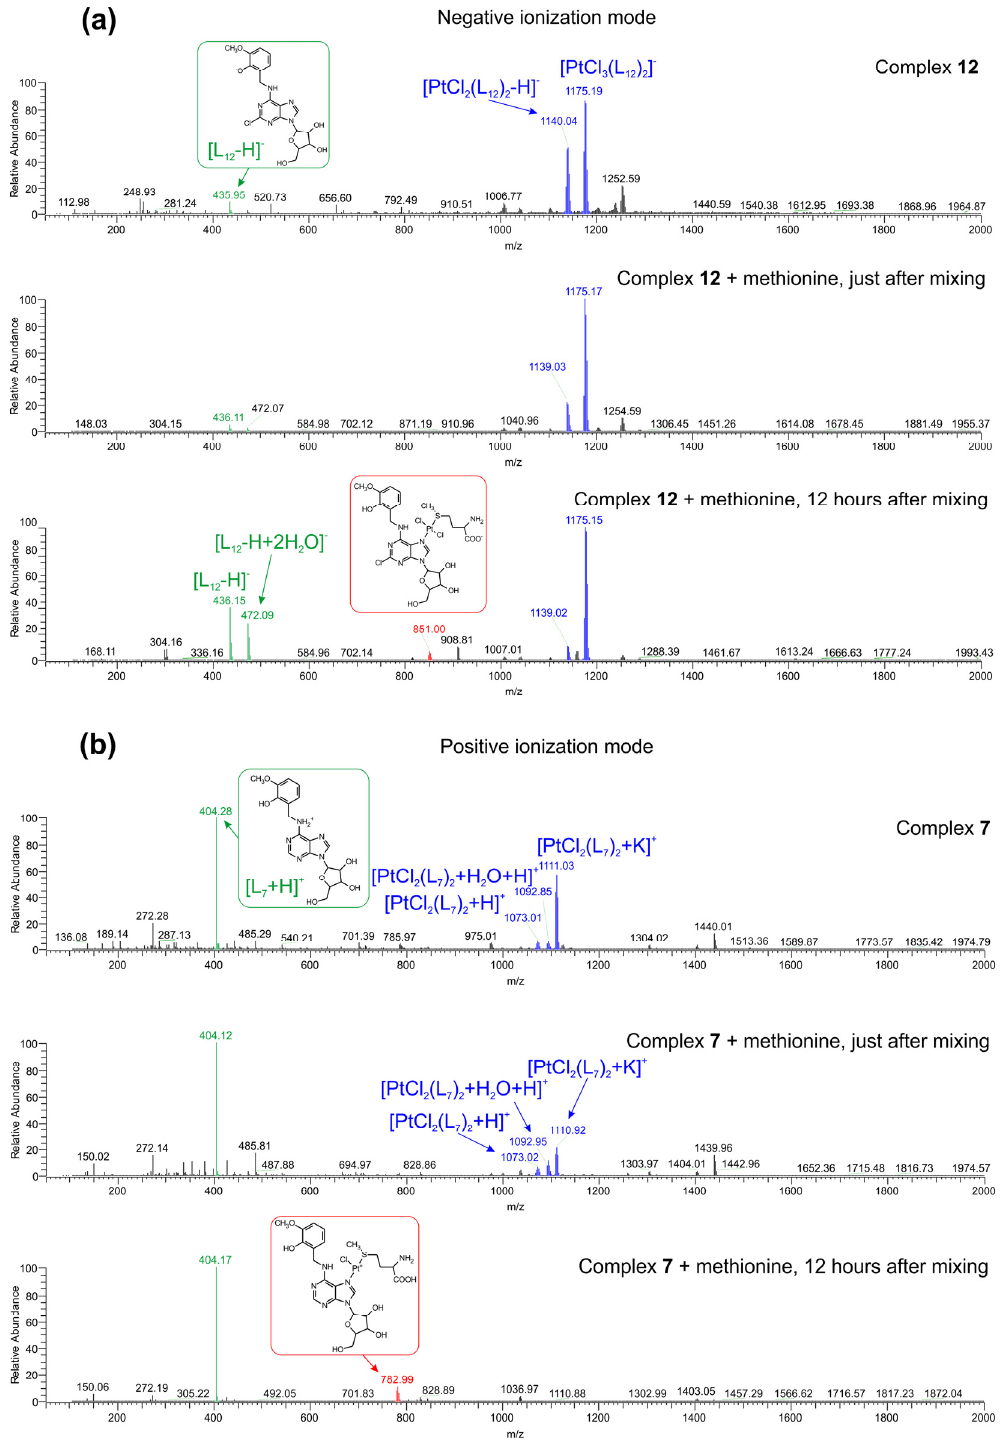
Figure 2. ( a ) The ESI − mass spectra of 12 (top spectrum), and interacting systems with L - methionine measured immediately after the preparation (middle spectrum) and 12 h after the preparation (lower spectrum); ( b ) the ESI+ mass spectra of 7 (top spectrum), and interacting systems with L -methionine measured immediately after the preparation (middle spectrum) and 12 h after the preparation (lower